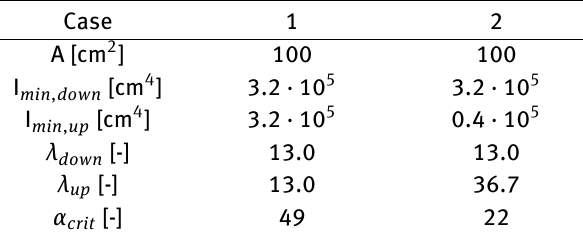
Figure 8: Four-member structure load-displacement curve